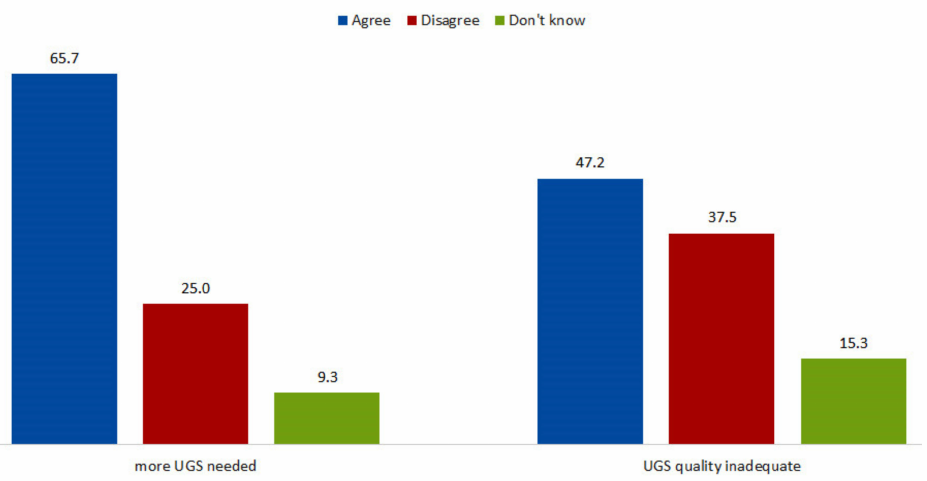
Figure 15. Demand for UGS ( n = 216) and its quality ( n = 216) according to Moscow residents’ opinion.